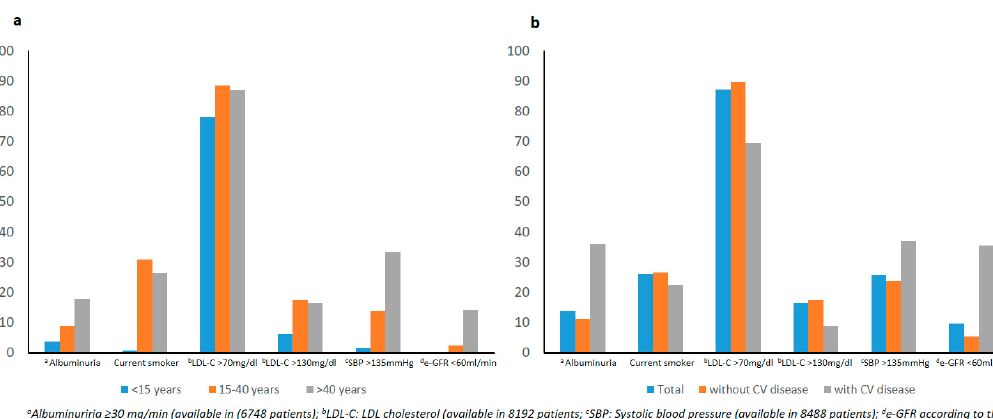
Figure 2. Prevalence of cardiovascular risk factors in T1D patients according to current age ( a ) and the absence/presence of cardiovascular disease ( b ).